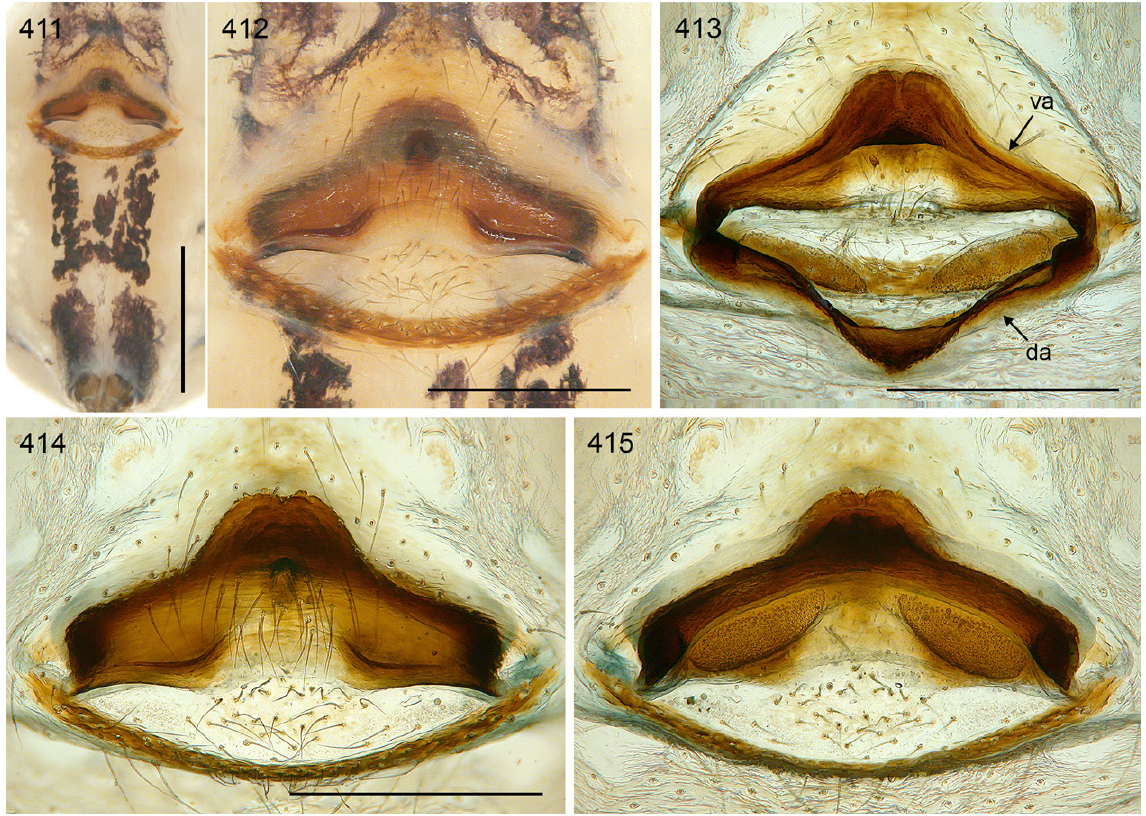
Figs 411–415. Crossopriza sahtan sp. nov.; female from Oman, above Wadi Sahtan (ZFMK Ar 22394). 411–412 . Abdomen and epigynum, ventral views. 413–415 . Female internal genitalia, dorsal view (with dorsal arc tilted backwards), ventral view, and regular dorsal view. Abbreviations: da = dorsal arc; va = ventral arc. Scale bars: 411 = 1.0 mm; 412–415 = 0.5